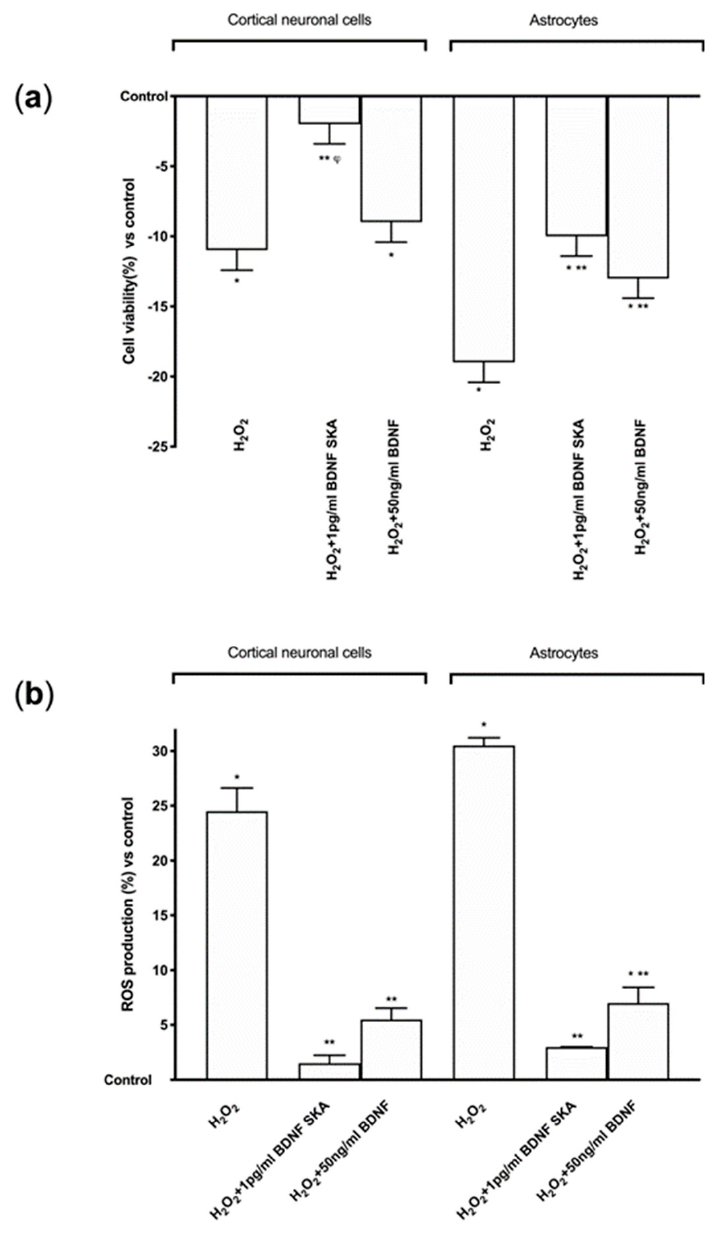
Figure 5. Cell viability and ROS production on both protocols in primary cortical neuronal cells and astrocytes under oxidative condition. ( a ) Cell viability and ( b ) ROS production measured in primary cortical neuronal cells (on the left) and astrocytes (on the right) after treatments. H 2 O 2 = 200 µ M H 2 O 2 added 30 min before stimulations. Data are expressed as means ± SD (%) of five independent experiments performed in triplicates normalized to control (0 line as control). * p < 0.05 vs. control; ** p < 0.05 vs. H 2 O 2 ; ϕ p < 0.05 vs. H 2 O 2 + 50 ng / mL BDNF in the same cells.